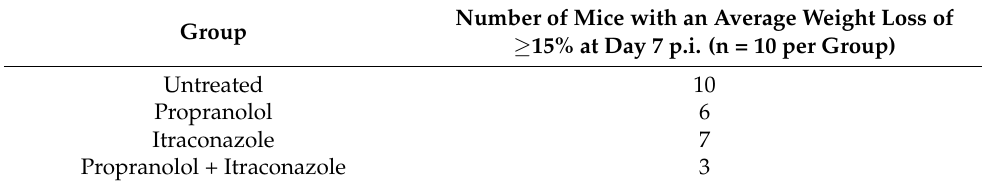
Table 2. Body weight loss of mice untreated or treated with antifungals. Number of Mice with an Average Weight Loss of Group ≥ 15% at Day 7 p.i. (n = 10 per Group) Untreated 10 Propranolol 6 Itraconazole 7 Propranolol + Itraconazole